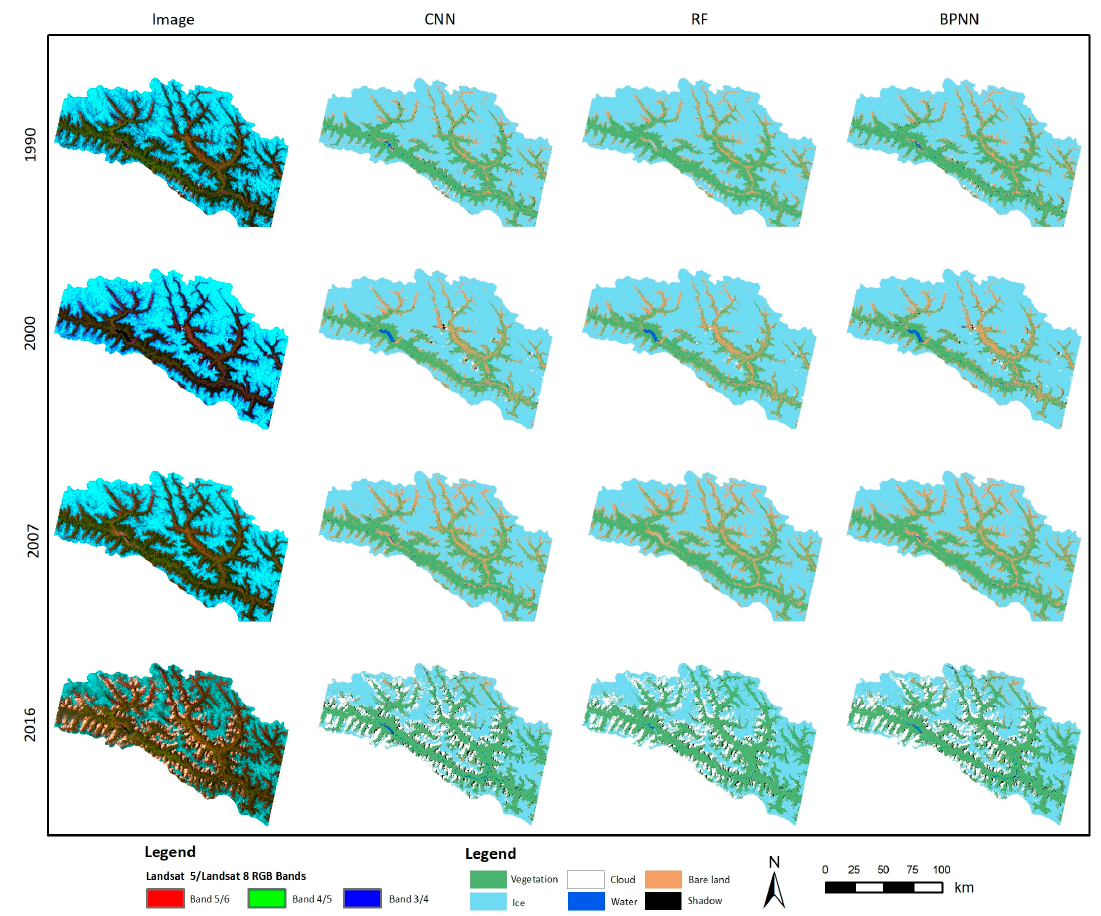
Figure 2. Classification results of the three methods. The first column represents the original image, and the second to fourth columns are the classification results of the three different algorithms: CNN, RF, and BPNN. Each row represents a fixed year; from top to bottom: 1990, 2000, 2007, and 2016. Table 4. Classification accuracy of the RF, CNN and BPNN model.